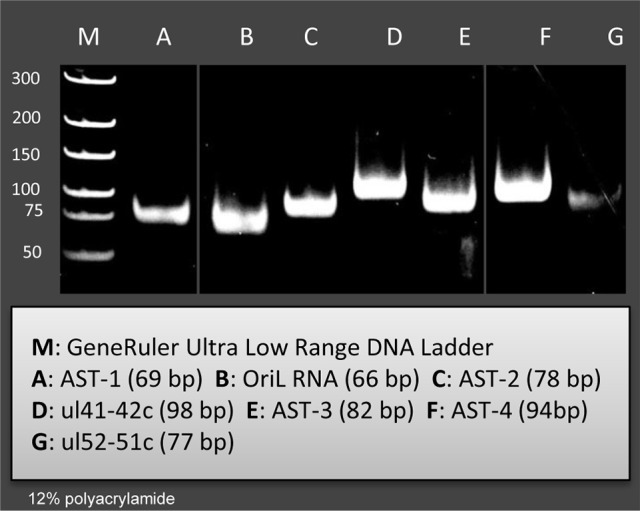
Validation and quantifying of antisense transcripts. Our PacBio analyses identified ten novel ncRNAs. We could confirm the expression of those transcripts with PCR analyses which were not embedded or overlapped with other transcripts. The following novel ncRNAs were detected by PCR (the sizes of PCR amplicons are in brackets): AST-1 (69 nts), (B2) OriL RNA (66 nts), AST-2 (78 nts), ul41-42c (98 nts), AST-3 (82 nts), AST-4 (94 nts), and ul51-52 c (77 nts).